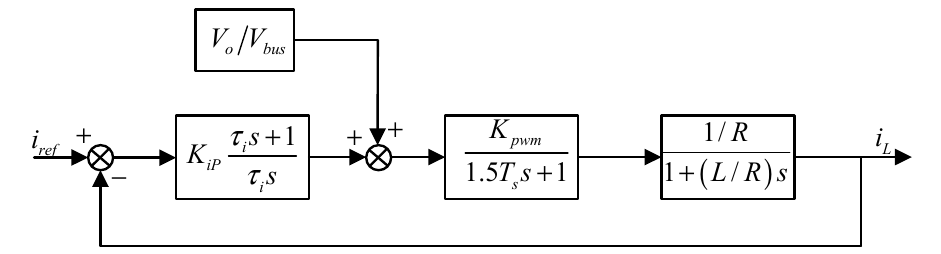
Figure 10. Diagram of feedforward and PI controller.